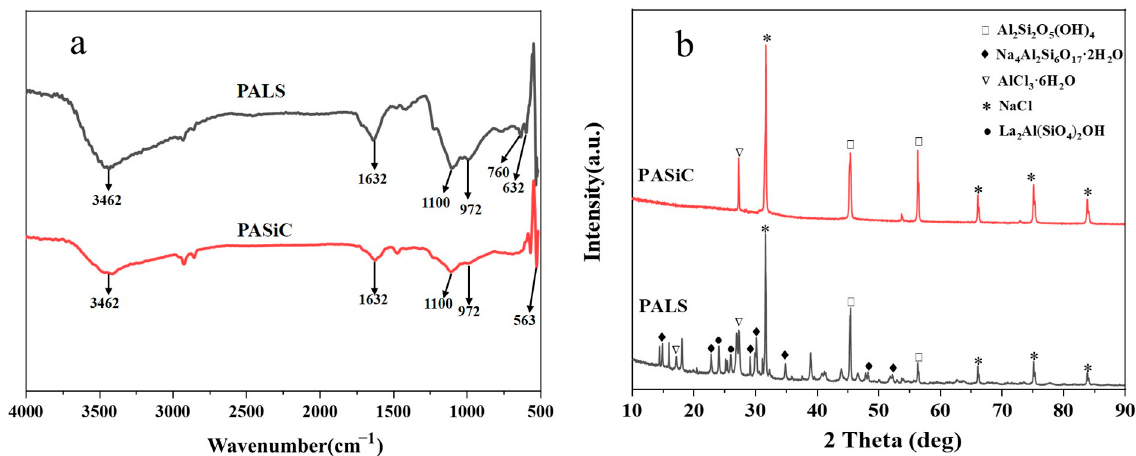
Figure 3. FTIR ( a ) and XRD patterns ( b ) for PALS and PASiC.